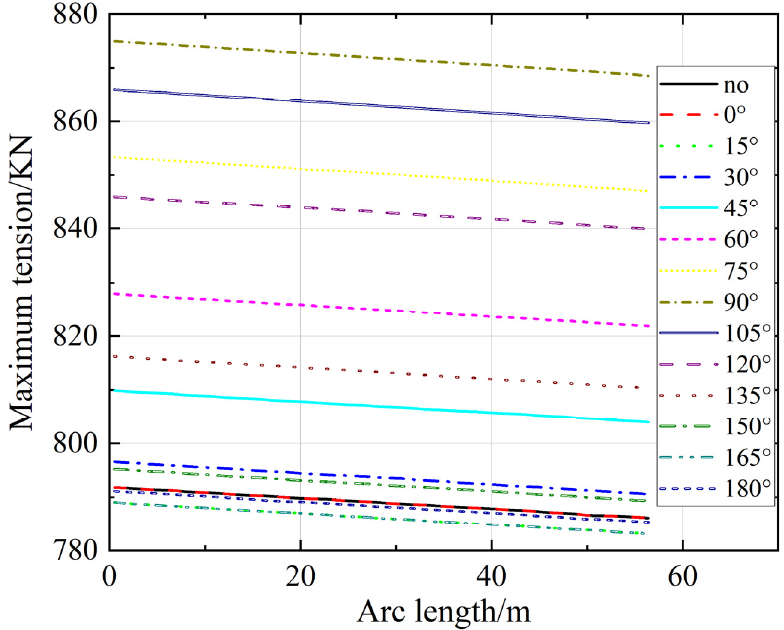
Figure 15. The maximum tension of the crane wire along the length direction.